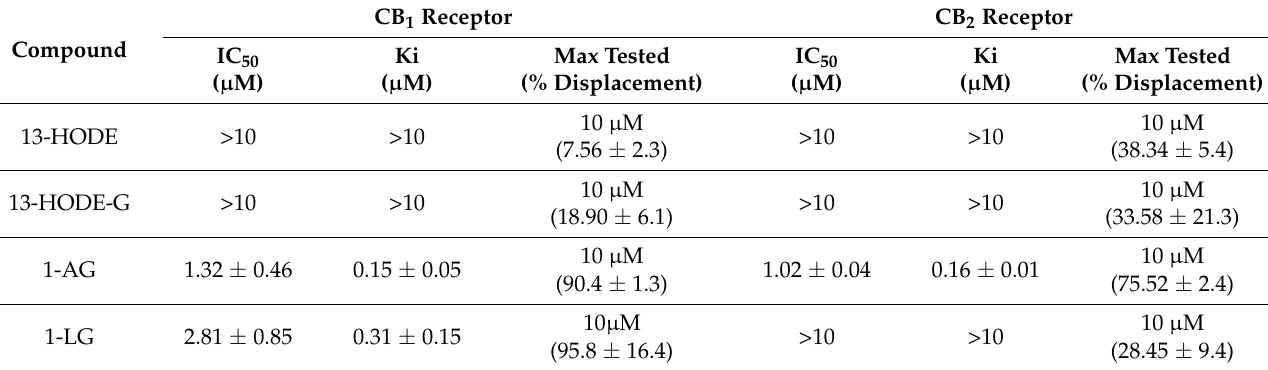
Table 4. Affinity of 13-HODE-G and related compounds for human recombinant CB 1 and CB 2 receptors. Results are shown as the mean ± SD.